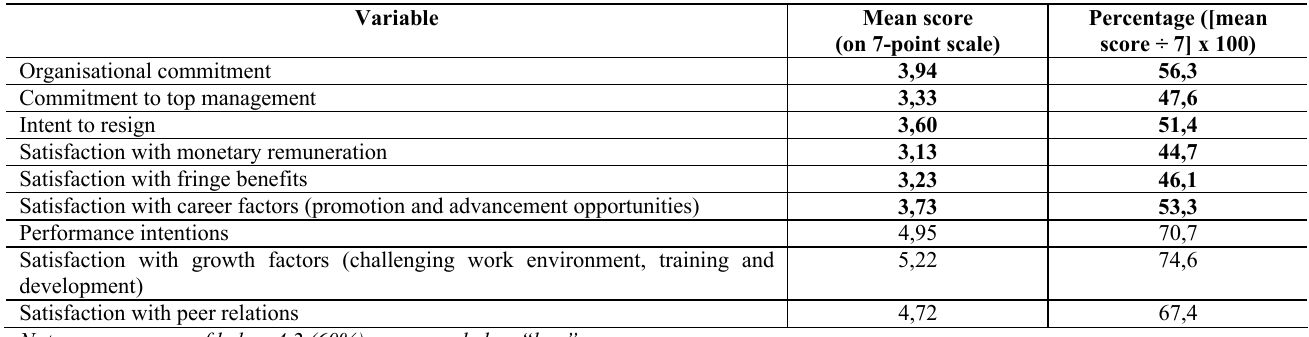
Table 4: Mean scores of